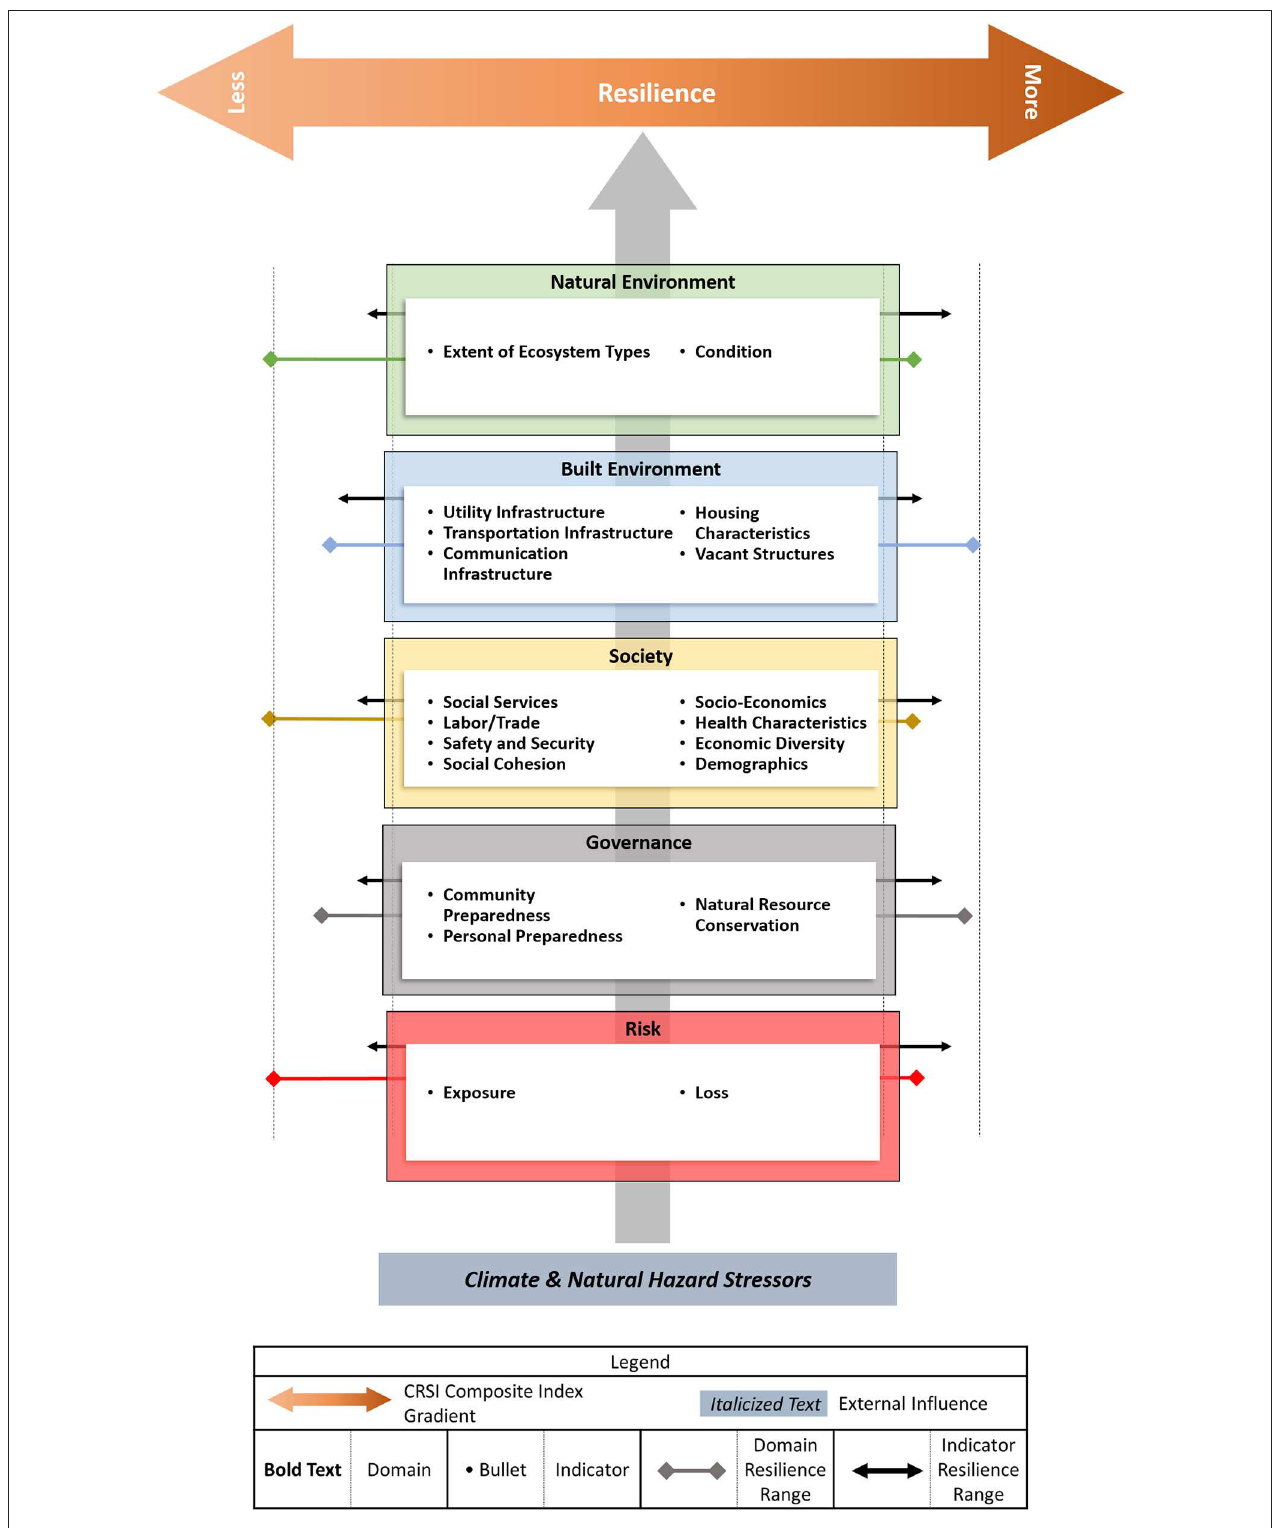
FIGURE 1 | The CRSI conceptual framework (Summers, K. et al., 2017). Lines extending left and right of domain labeled boxes depict a theoretical range of socio-economic and ecological recoverability factors that may influence the overall CRSI measure. Black arrows relate to indicators and color, diamond-ended lines are assigned to domains highlighted by the same